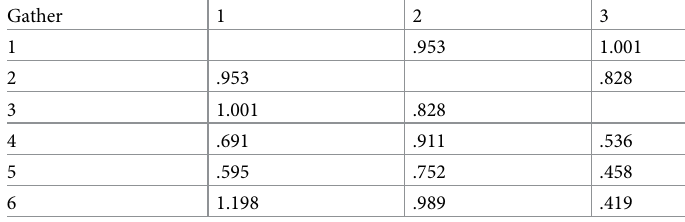
Then, based on the above chosen attribute benchmark, the number of observed values in each cluster is present in Table 5, the case number corresponding to the cluster class is in Table 4, and the sample data corresponding to the serial number of metrology objects can be found in Table 1. The average value is calculated as the attribute benchmark value. Calculates